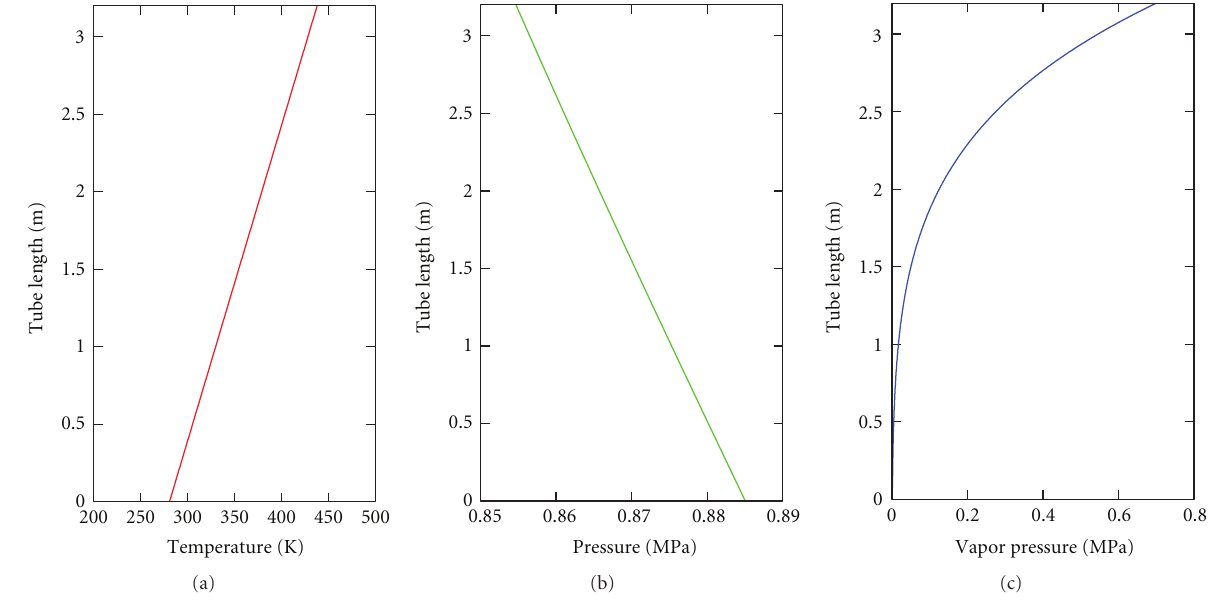
Figure 2: Initial conditions of the